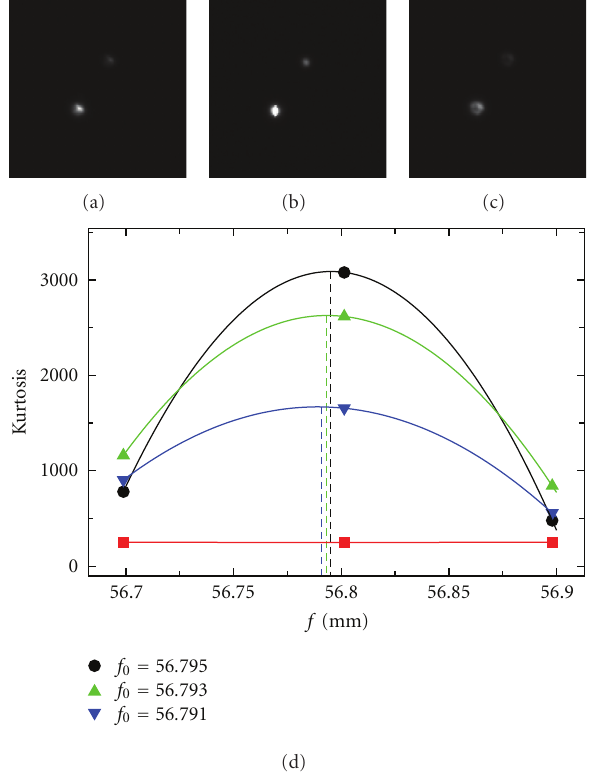
Figure 9: The kurtosis of the ADU statistics on three images taken with WiFSIP during precommissioning on Robotel, at the Astrophysical Institute in Potsdam. All three quadrants of the imaging CCD with bright stars in them show a peaking kurtosis close to the best focus position. The one flat line is the kurtosis in quadrant 1, which was essentially free of stars. The small inserts on top are tiny windows around two bright stars in the field at the di ff erent focus